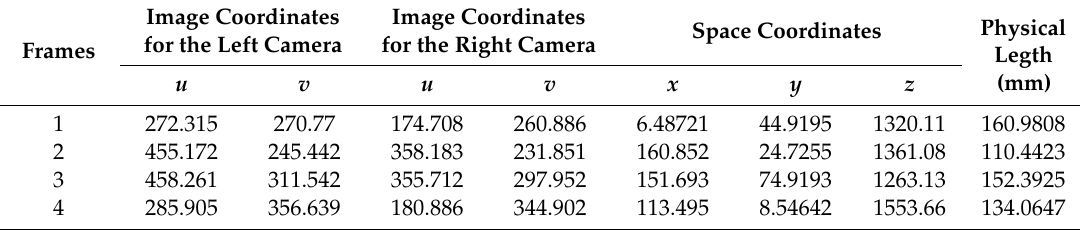
Table 6. Binocular vision measurements from group 3.